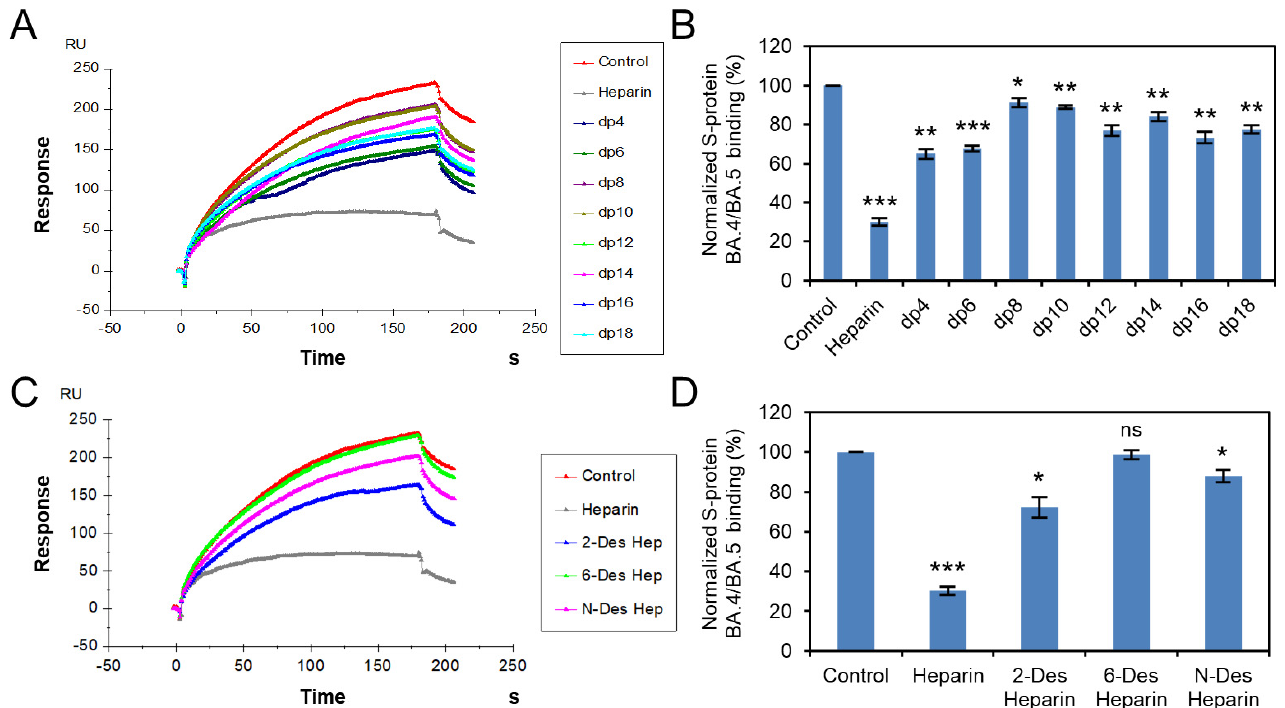
Figure 4. S protein RBD (BA.4/BA.5)–heparin interaction inhibited by heparin oligosaccha- rides/desulfated heparins using solution competition. ( A ) SPR sensorgrams of S protein RBD (BA.4/BA.5)–heparin interaction competing with different heparin oligosaccharides. Concentration of S-protein RBD (BA.4/BA.5) is 250 nM mixed with 1 µM of different heparin oligosaccharides. ( B ) Bar graphs (based on triplicate experiments with standard deviation) of normalized S-protein RBD (BA.4/BA.5) binding preference to surface heparin by competing with different heparin oligosac- charides. ( C ) SPR sensorgrams of S protein RBD (BA.4/BA.5)–heparin interaction competing with different desulfated heparins. Concentration of S-protein RBD (BA.4/BA.5) is 250 nM mixed with 1 µM of different desulfated heparins. ( D ) Bar graphs (based on triplicate experiments with standard deviation) of normalized S-protein RBD (BA.4/BA.5) binding preference to surface heparin by com- peting with different desulfated heparins. Statistical analysis was performed using unpaired two- tailed t -test (ns: p > 0.05 compared to the control, *: p ≤ 0.05 compared to the control, **: p ≤ 0.01 compared to the control, ***: p ≤ 0.001 compared to the control).